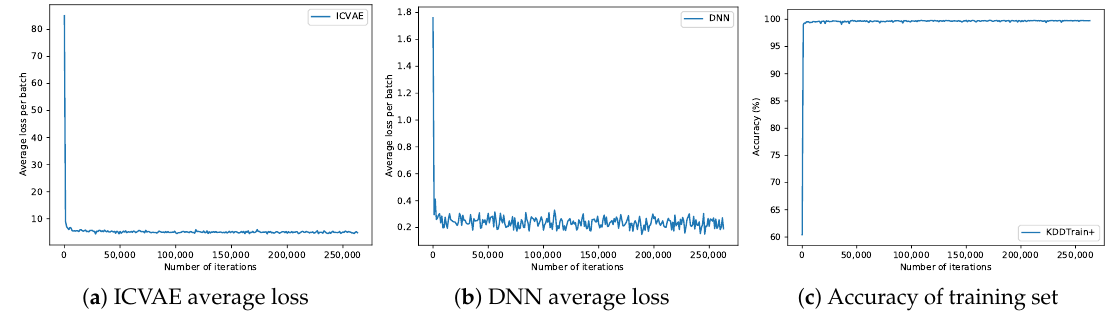
Figure 5. Training charts on the NSL-KDD